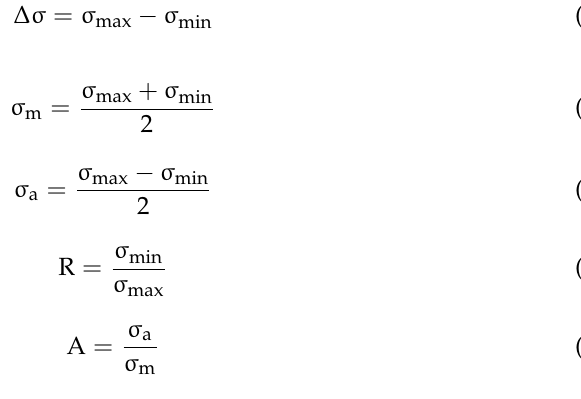
Table 9. Stress ratio and amplitude ratio according to load condition.